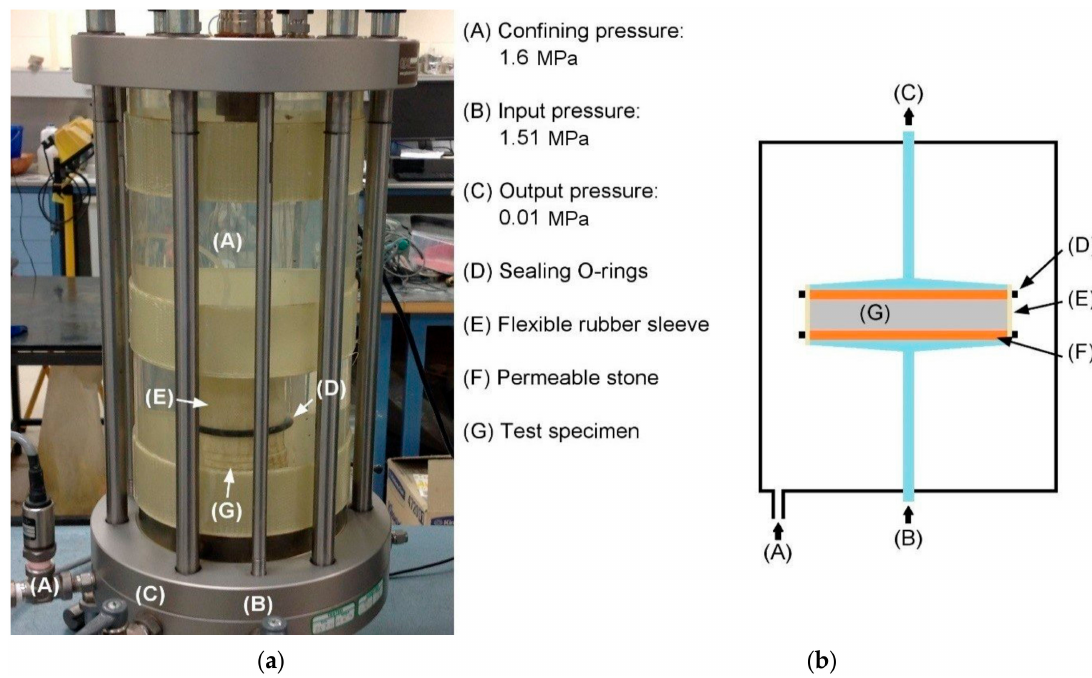
Figure 3. Experimental permeameter cell used in this study. Annotated photograph of the setup ( a ) and ( b ) a basic schematic representation of the equipment.